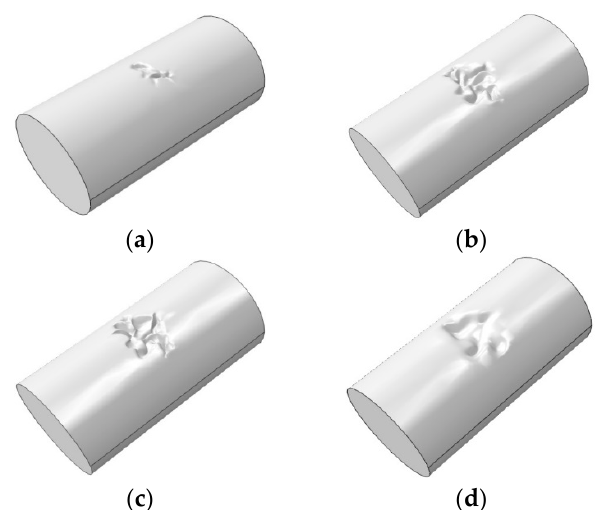
Figure 7. Pre-corroded steel wire model and its size.